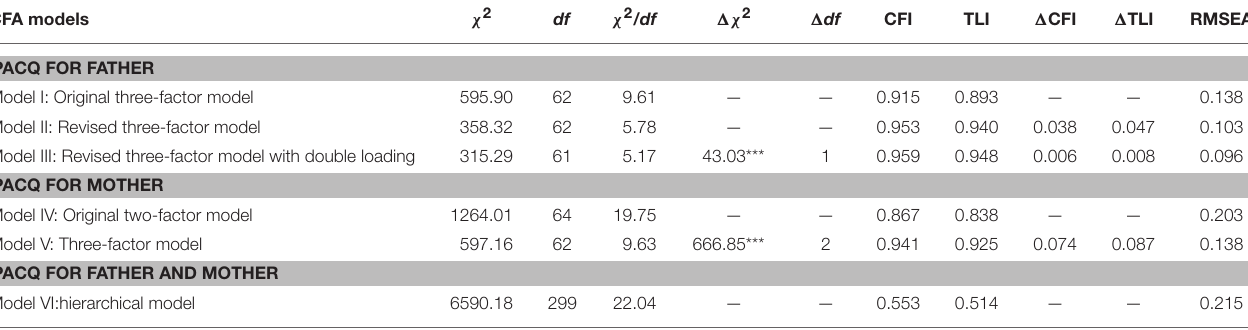
TABLE 5 | Comparison of several PACQ fit indices for the estimated